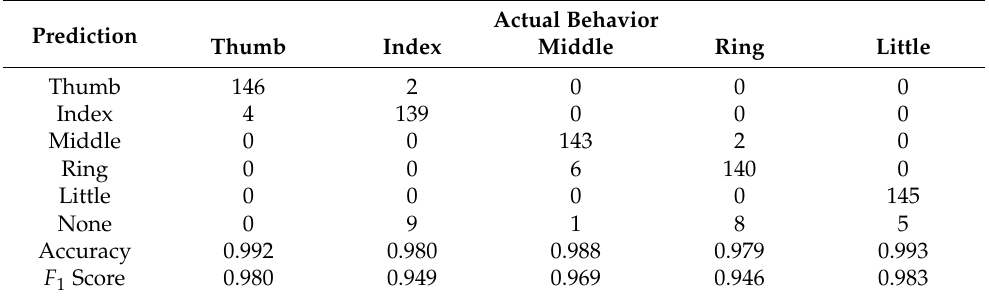
Table 1. Confusion matrix for accuracy and F 1 score analysis for individual finger